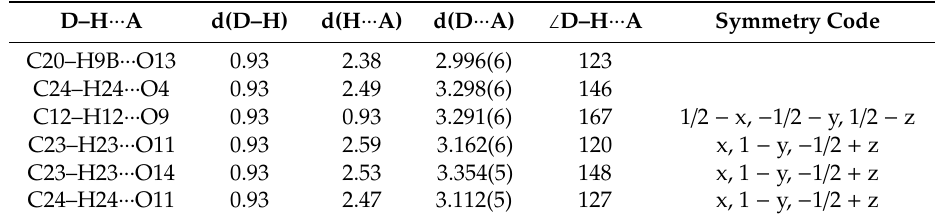
Table 3. Hydrogen-bonding interactions (Å, ◦ ) of the [Zn II 2 –Sm III 2 ] complex.